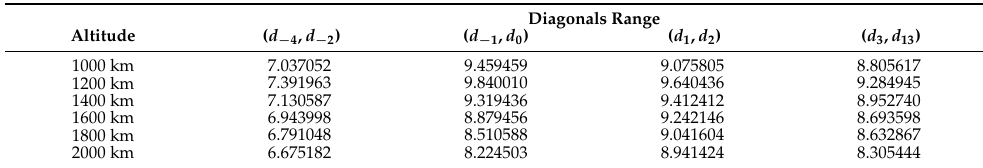
Table 7. Rate parameter, b × 10 − 2 , for matrix P b , using the diagonal notation as in (19), and as shown in Figure